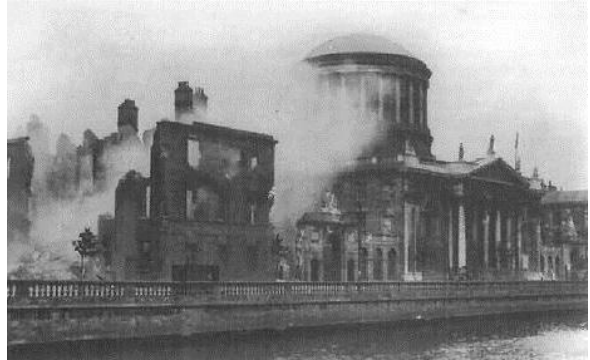
Figure 1: War Damage to the Four Courts